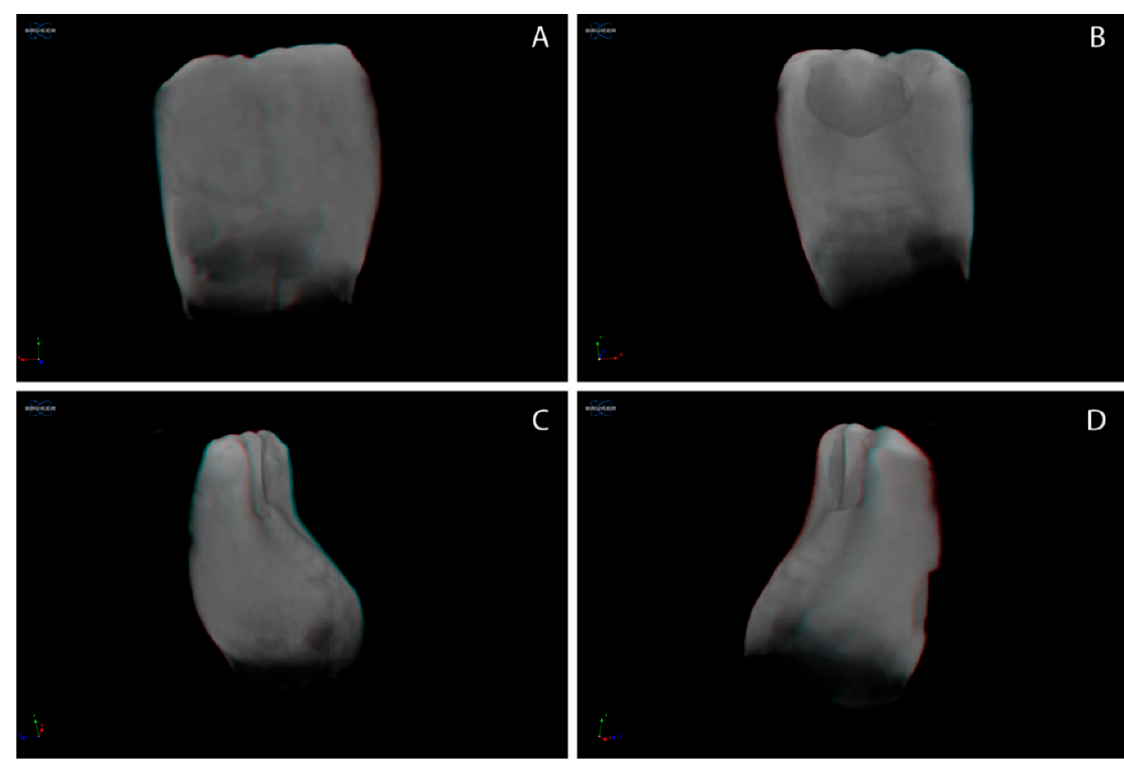
Figure 1. Representative 3D reconstructed natal tooth. ( A ) buccal view; ( B ) palatal view; ( C , D ) prox- imal views.